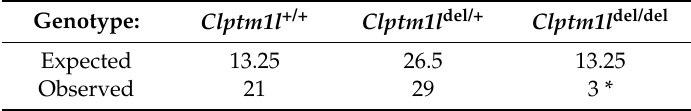
Table 1. Genotypes of offspring from Clptm1l del/+ with Clptm1l del/+ mating.